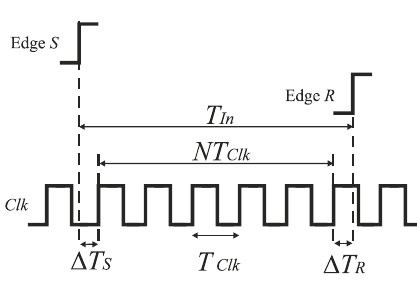
Figure 2. Time-to-digital conversion in counter-based TDC.